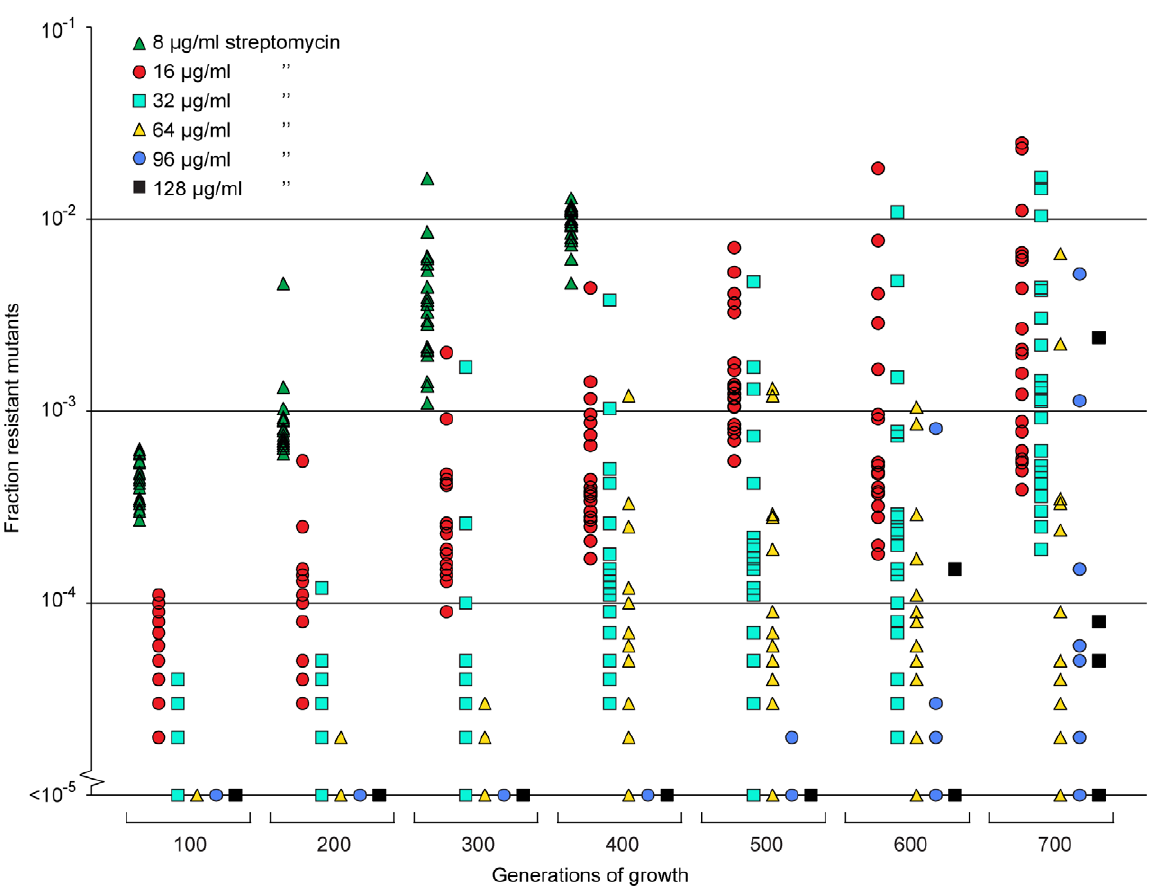
Figure 5. Selection of denovo resistant mutants at sub-inhibitory concentrations of antibiotics. A total of 20 independent lineages of S. typhimurium were serially passaged in Mueller-Hinton medium containing 1 m g/ml streptomycin. Every 100 generations approximately 10 5 cells were plated onto LB agar containing different concentrations of streptomycin and the fractions of resistant mutants were calculated. The data points are grouped by number of generations of growth and resistance level, and in each of these data sets one data point represents the fraction of cells present in one lineage capable of growth at the specified antibiotic concentrations. Please note that data points at the baseline will overlap.